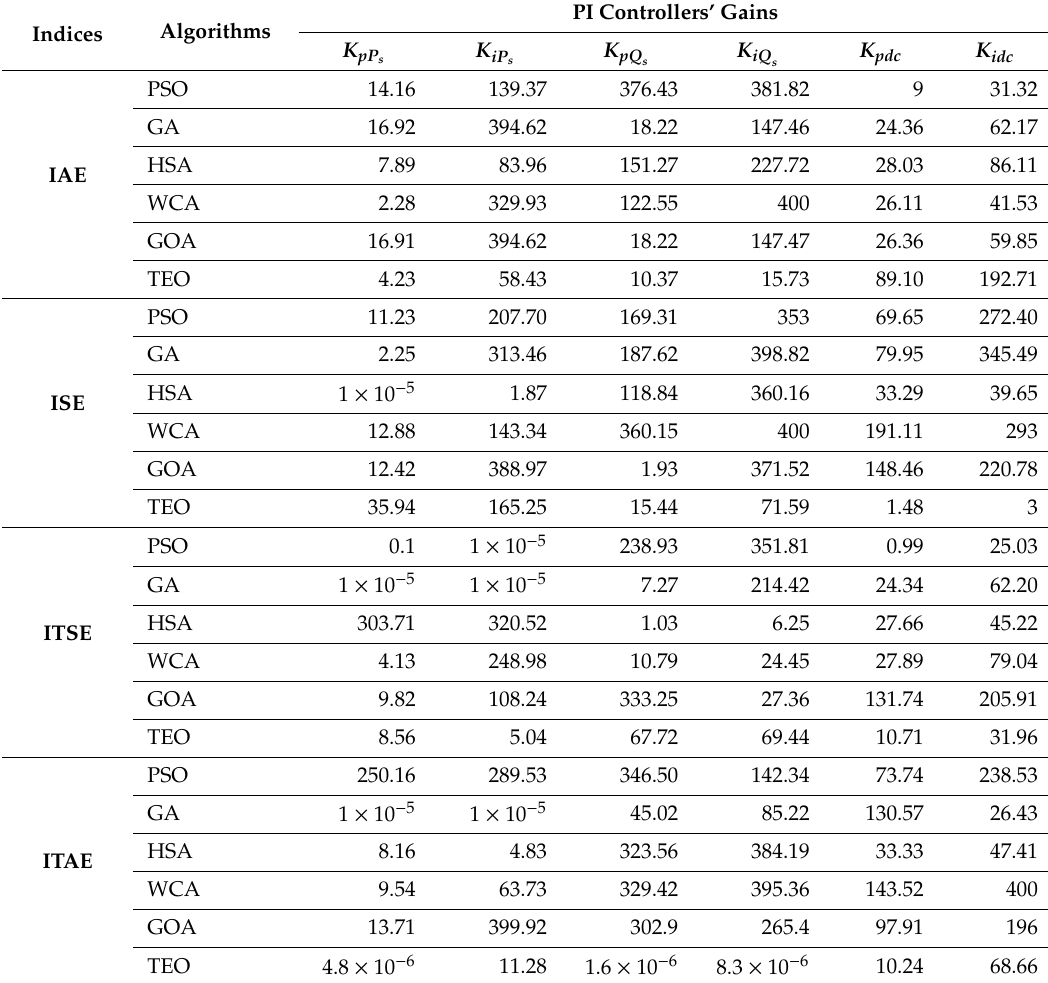
Table A1. Comparative results of the PI controllers’ coe ffi cients